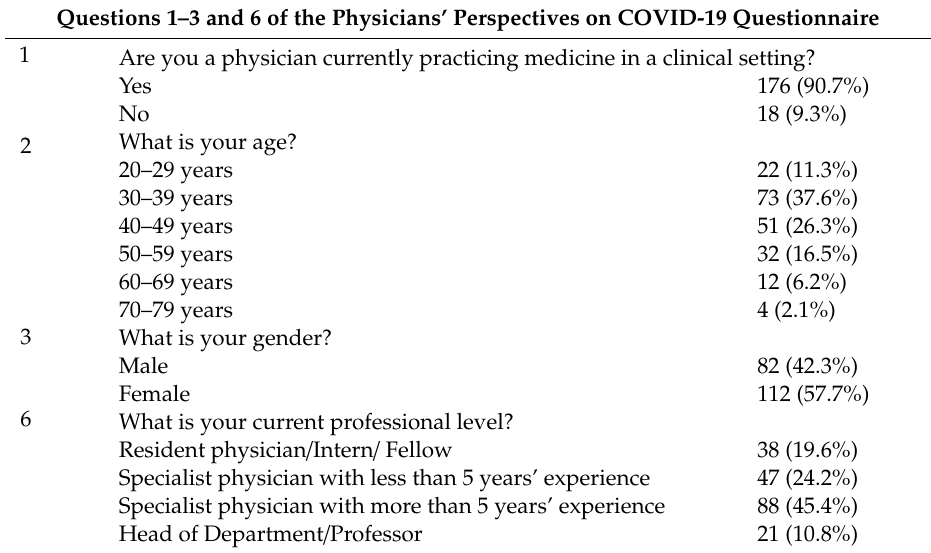
Table 1. Demographic data of the study